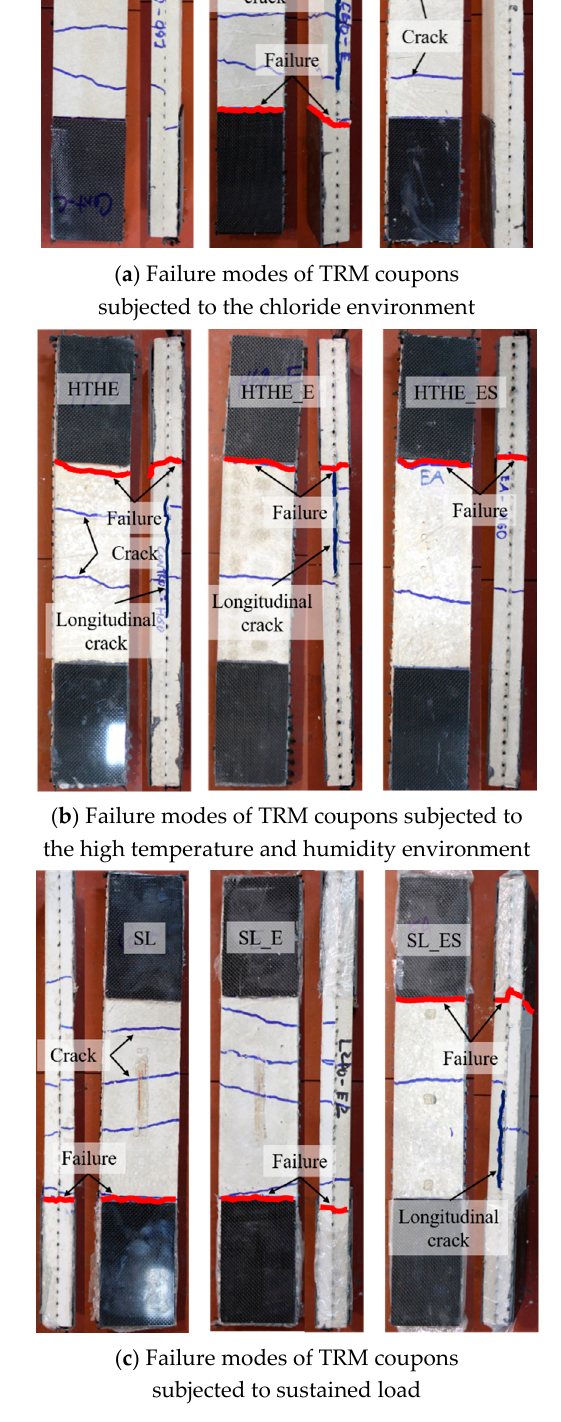
Figure 9. Failure modes of TRM test coupons.